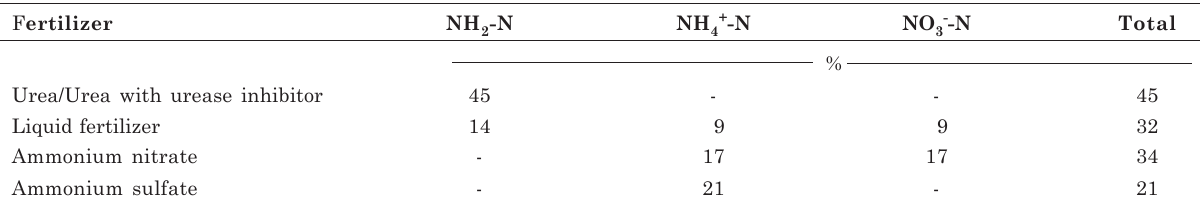
Table 2. Content and forms of N in the fertilizers used in the